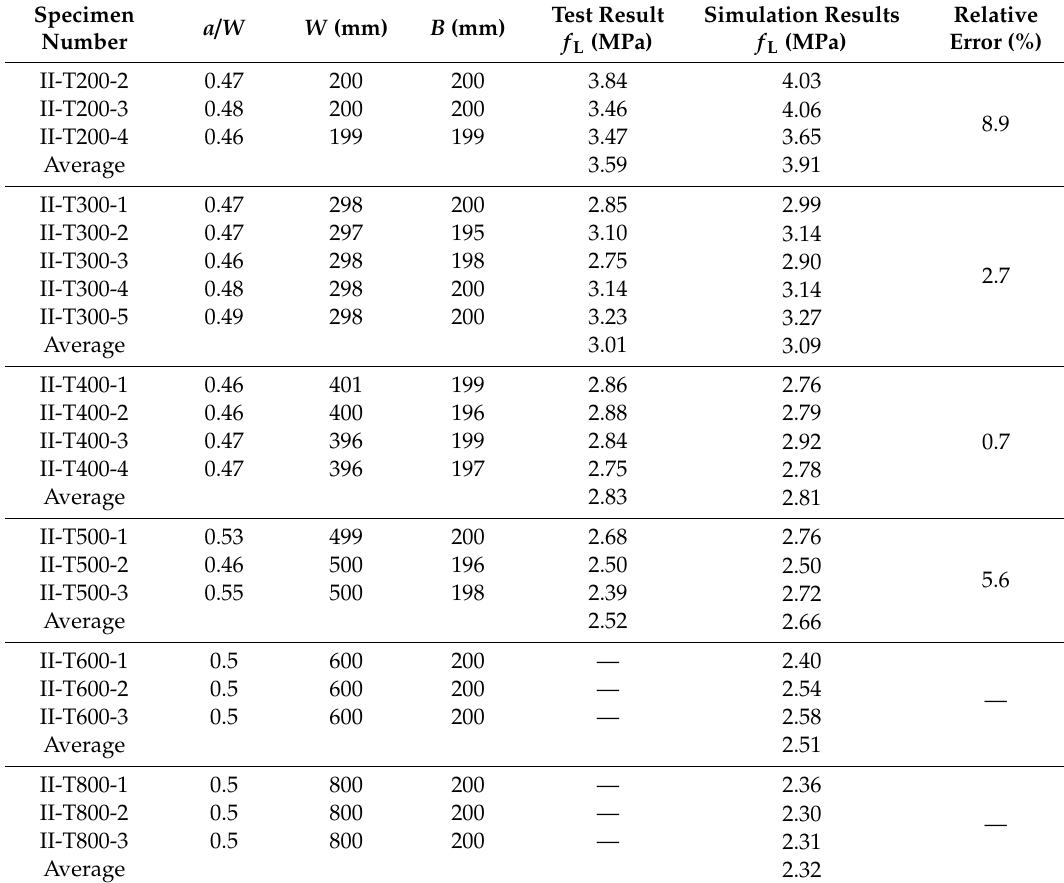
Table 4. Numerical simulation results for 3-p-b